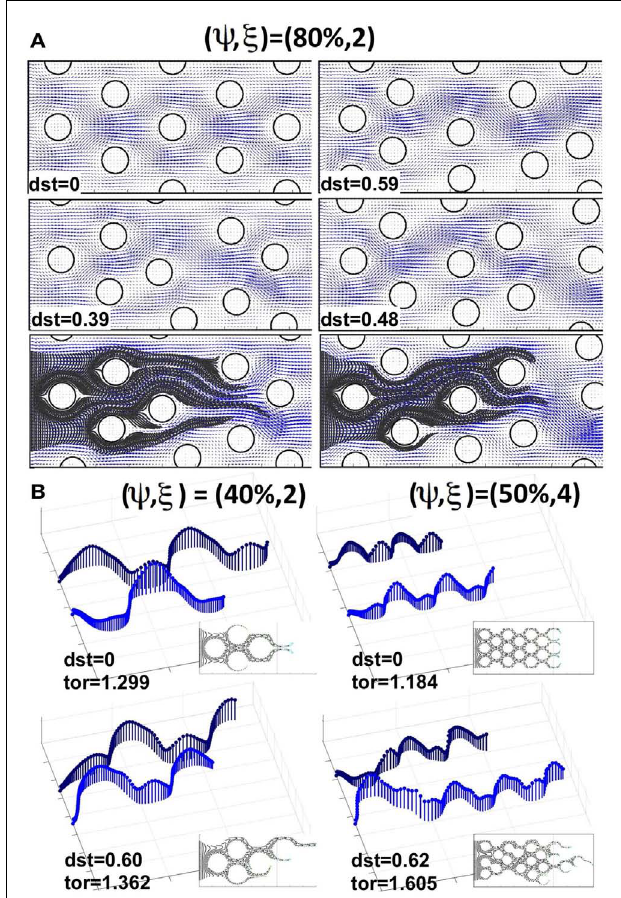
FIGURE 5 | Comparison of drug particle traces and tortuosity in regular and irregularly perturbed tissue geometries . (A) A regularly packed tissue (upper left corner) and three cases of irregular geometries (upper right corner and middle row), all with a cellular porosity of ψ = 80% and cellular density of ξ = 2 cells, together with the resulting interstitial fluid velocity fields and indicated distortion (dst). Bottom row: traces of drug particles along the “corridors” with a higher interstitial fluid flow for the two irregular geometries shown in the middle row. (B) The effective paths of two representative drug particles (the same in each tissue) for a pair of regularly and irregularly packed tissues: ( ψ , ξ ) = (40%, 2) and ( ψ , ξ ) = (50%, 4).The length of each vector (blue) indicates the speed of a particle at the given position. Insets show traces of several other drug particles for the given tissue topology.The maximal tortuosity values (tor) for each tissue are